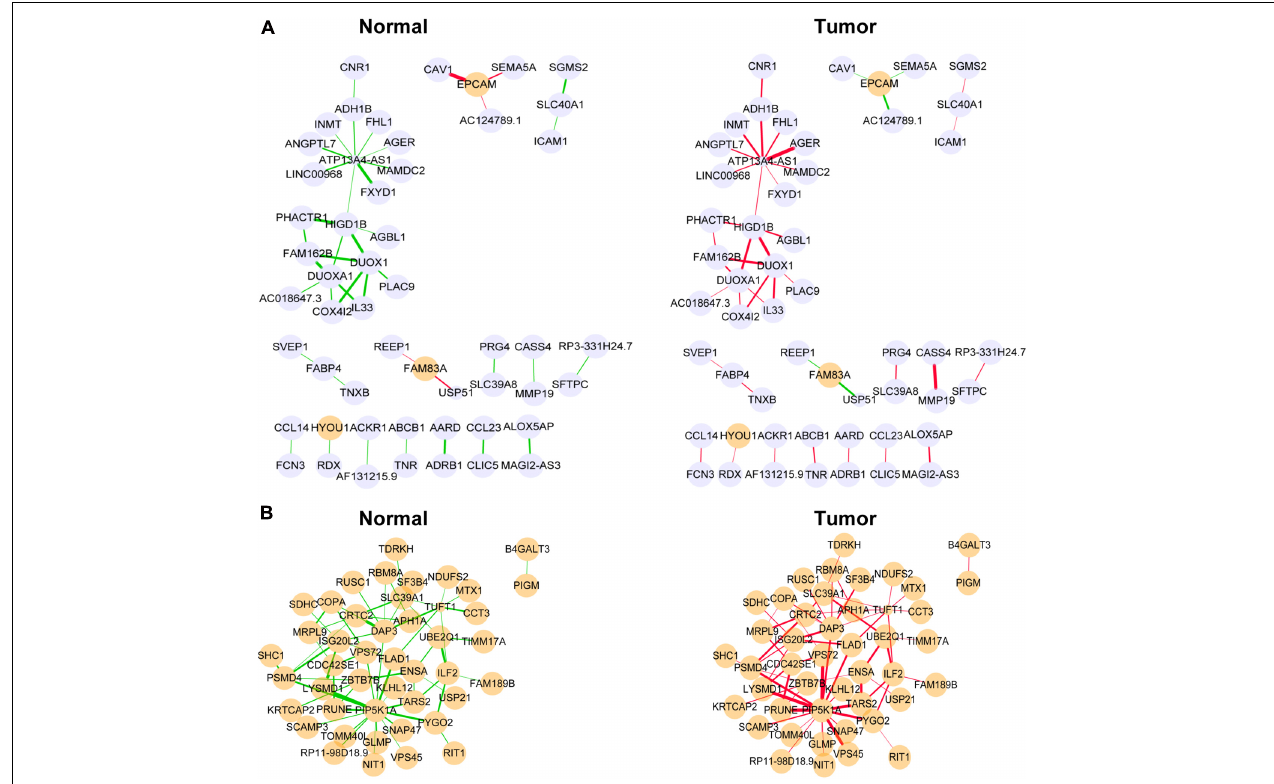
FIGURE 5 | Differentially co-expressed gene networks in the yellow (A) and medium orchid (B) modules from the TCGA dataset. Each node represented a gene, with lavender-filled color denoting downregulation and orange-filled color upregulation. The larger size of node represented smaller adjusted P -value. The edge represented connection between two genes. The green edge represented negative correlation and red positive correlation. The thicker part of the edge represented a stronger correlation